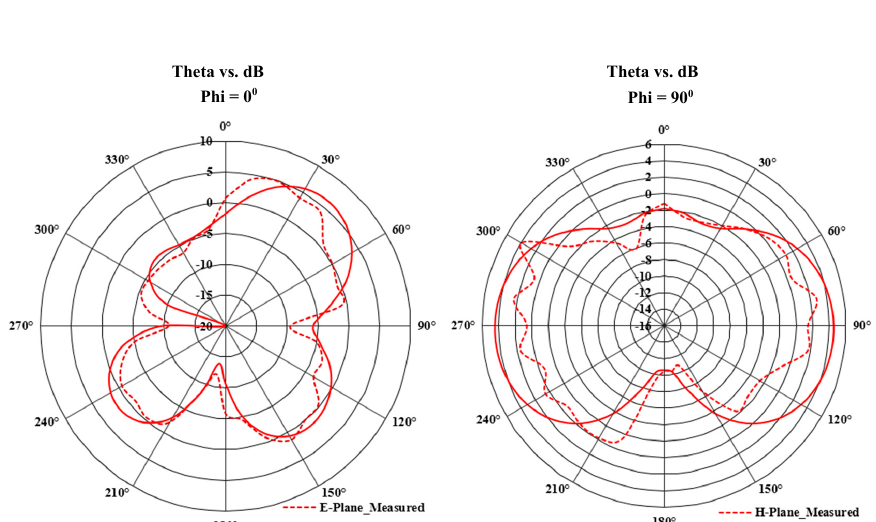
Figure 13. Gain vs. frequency graph of the proposed UWB antenna. 5. Comparative Study Finally, Table 4 compares the proposed antenna from this work to the MTM-based antennas that have been previously reported in [12,18,29,31,32,35] in terms of size, sub- strate dielectric constant, number of notch-bands, controllability of the notch-band band- width and frequency, technique, the complexity of the design, and operational band- width. It can be observed from Table 4 that, out of all the antennas presented, nearly all of them are unable to control the notch-bandwidth and frequency. The antenna reported in [12,18] has a single notch-band with compact size and only the article [18] has demon- strated the feature of controlling only one notch-band bandwidth. The antennas described in [31,32] provide triple notch-bands based on the MTM technique, but the former lack the benefits of controllable notch-bandwidth and frequency, and the latter have the draw- back of a complex design with the option of just one controllable notch-bandwidth and frequency, which is caused by the presence of a varactor diode. The antenna designs in- dicated in [29,35] offer a dual notch-band without notch-bandwidth and frequency con- trollable benefits; the former has a compact size, while the latter has a large size. Most of the antenna designs presented in Table 4 use high-end substrates. In summary, the pro- posed inverted triangular antenna has the features of low-cost, compact size, and simple design with the option of controllable bandwidth and frequency of the notch and